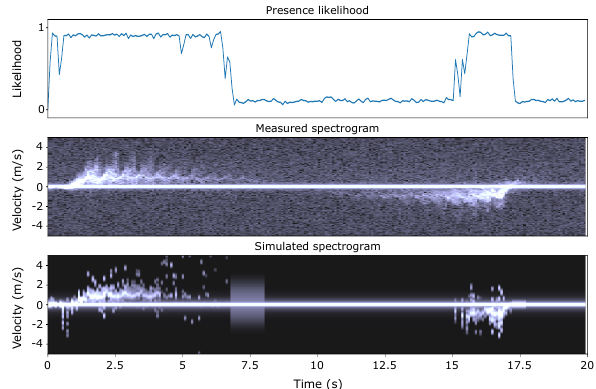
Figure 5. Particle filter results on the signal of a person walking away from the sensor and then back